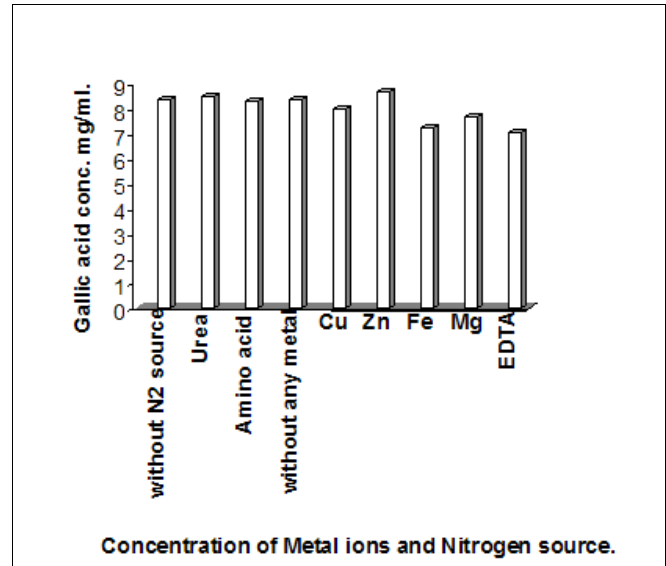
Figure 2. Effect of nitrogen source, metal ions and chelating agent on gallic acid